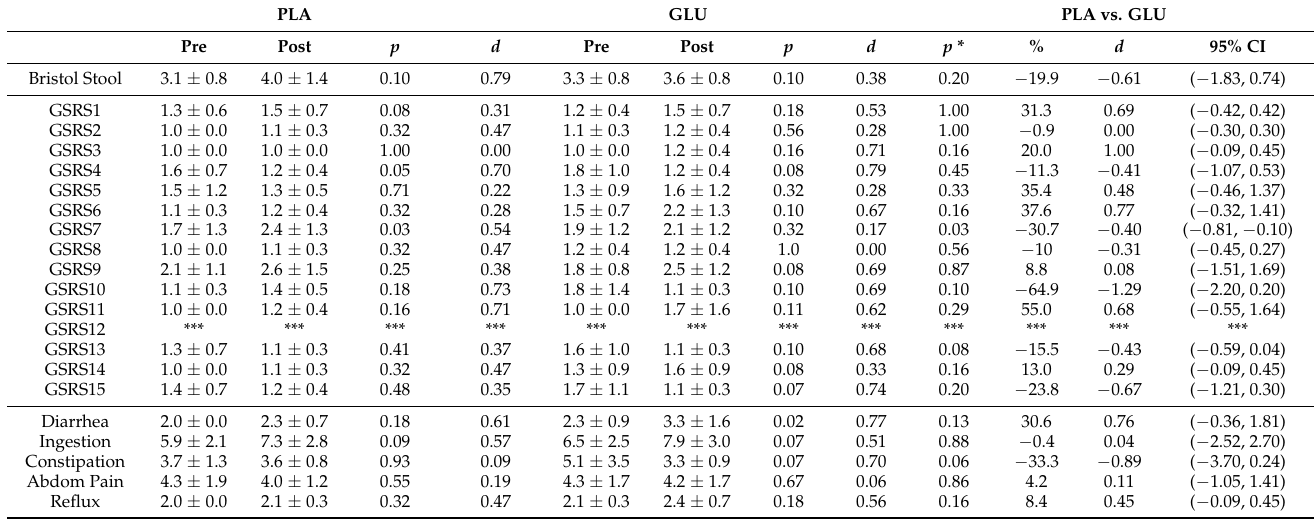
Values inside table are means ± standard deviations for each specified variable and timepoint. Bold-type face = Between-group difference ( p < 0.05). * = p -value computed using non-parametric statistical approaches (Wilcoxon-signed rank test). GSRS1 = Pain and discomfort in upper abdomen or stomach; GSRS2 = Heartburn; GSRS3 = Acid reflux; GSRS4 = Hunger pangs; GSRS5 = Nausea; GSRS6 = Stomach rumbling; GSRS7 = Stomach bloating; GSRS8 = Burping; GSRS9 = Passing gas or flatulence; GSRS10 = Constipation; GSRS11 = Diarrhea; GSRS 12 = (***) Was not assessed due to technical error; GSRS13 = Hard stools; GSRS14 = Urgent need to have a bowel movement; GSRS15 = Sensation of not completely emptying the bowels; Diarrhea = Combined score of GSRS11 and GSRS14; Ingestion = Combined score of GSRS6, GSRS7, GSRS8, and GSRS9; Constipation = Combined score of GSRS10, GSRS13, and GSRS14; Abdom Pain = Combined score of GSRS 1, GSRS4, and GSRS5; Reflux = Combined score of GSRS2 and